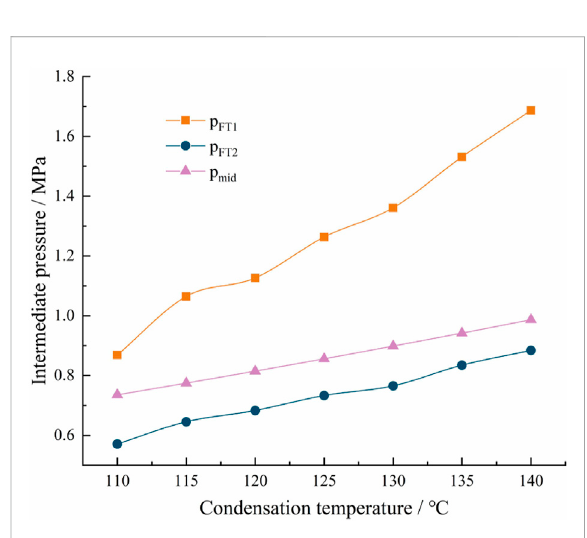
FIGURE 7 Variable relationship of intermediate pressure at different condensation